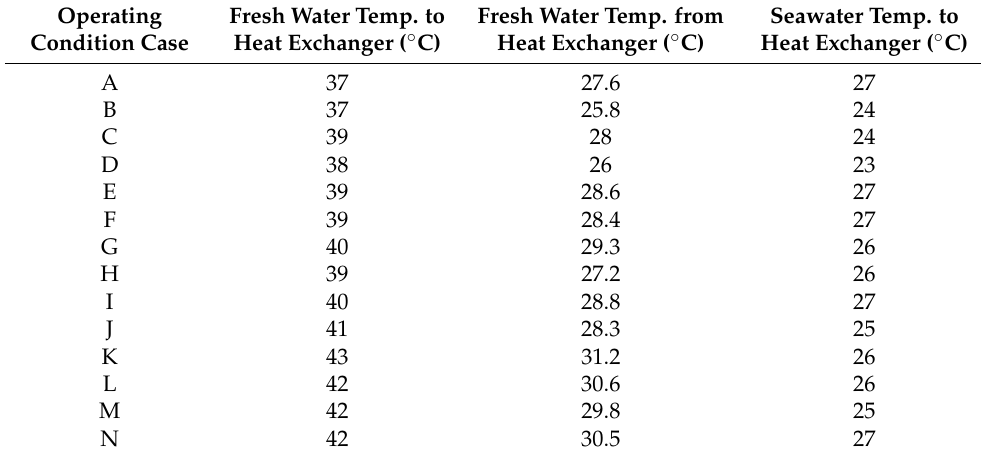
Table 1. Record of central FW cooling system in actual ship operation.